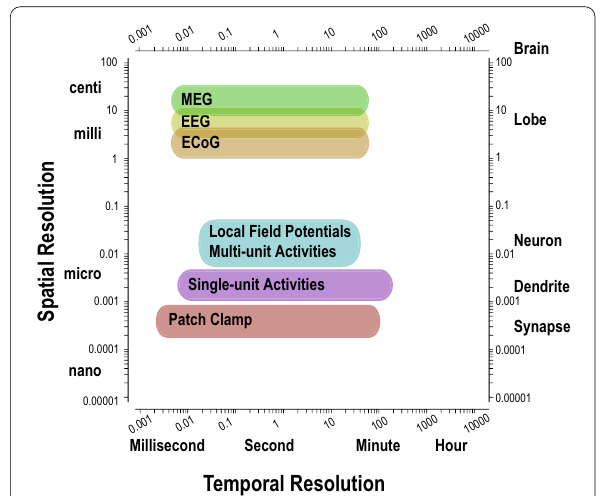
Fig. 2 Spatio-temporal resolution of EEG, MEG, ECoG, LFP, multi-unit activities, single-unit activities and patch-clamp recordings. Modified from